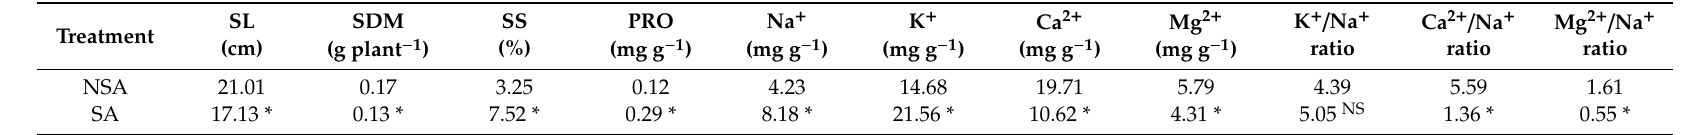
Table 2. Growth and physiological characteristics of alfalfa ( Medicago sativa L.) under two treatments.